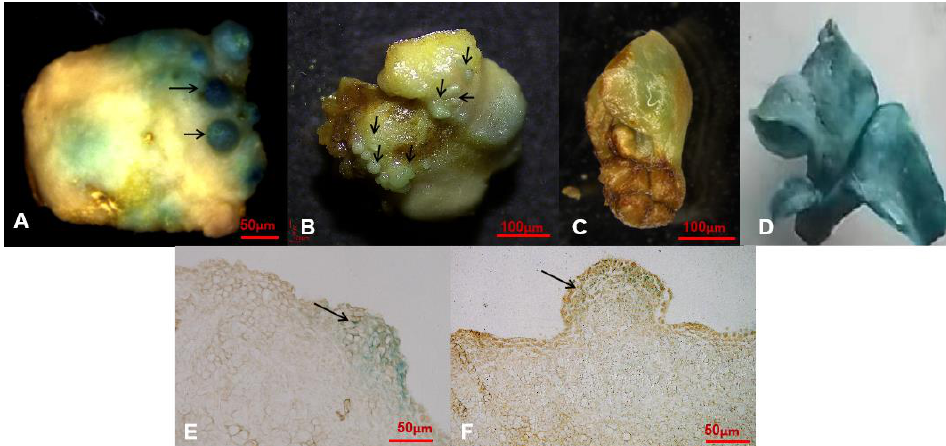
Figure 4. Secondary somatic embryos expressing GUS gene. ( A ) Eighteen days culture with evident GUS-carrying globular embryo development; ( B ) twenty-five days culture with GUS-positive globular embryos under a kanamycin selection pressure of 100mg/L; ( C ) cotyledonary secondary somatic embryos from 45-day-old cultures; ( D ) GUS expression in transgenic SEs; ( E ) a cross section of secondary embryos with GUS signals, 14-day-old cultures; ( F ) secondary globular embryo showing GUS signals, 18-day-old cultures. Bars are 50 μm and 100 μm. Black arrows indicate GUS expressions.